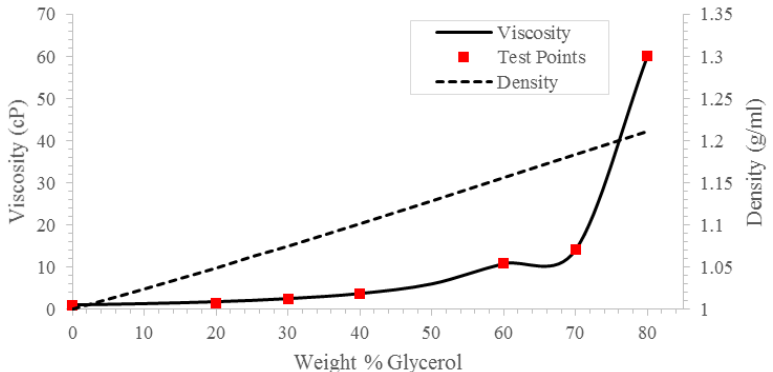
Figure 12. Density and viscosity as a function of weight % glycerol.